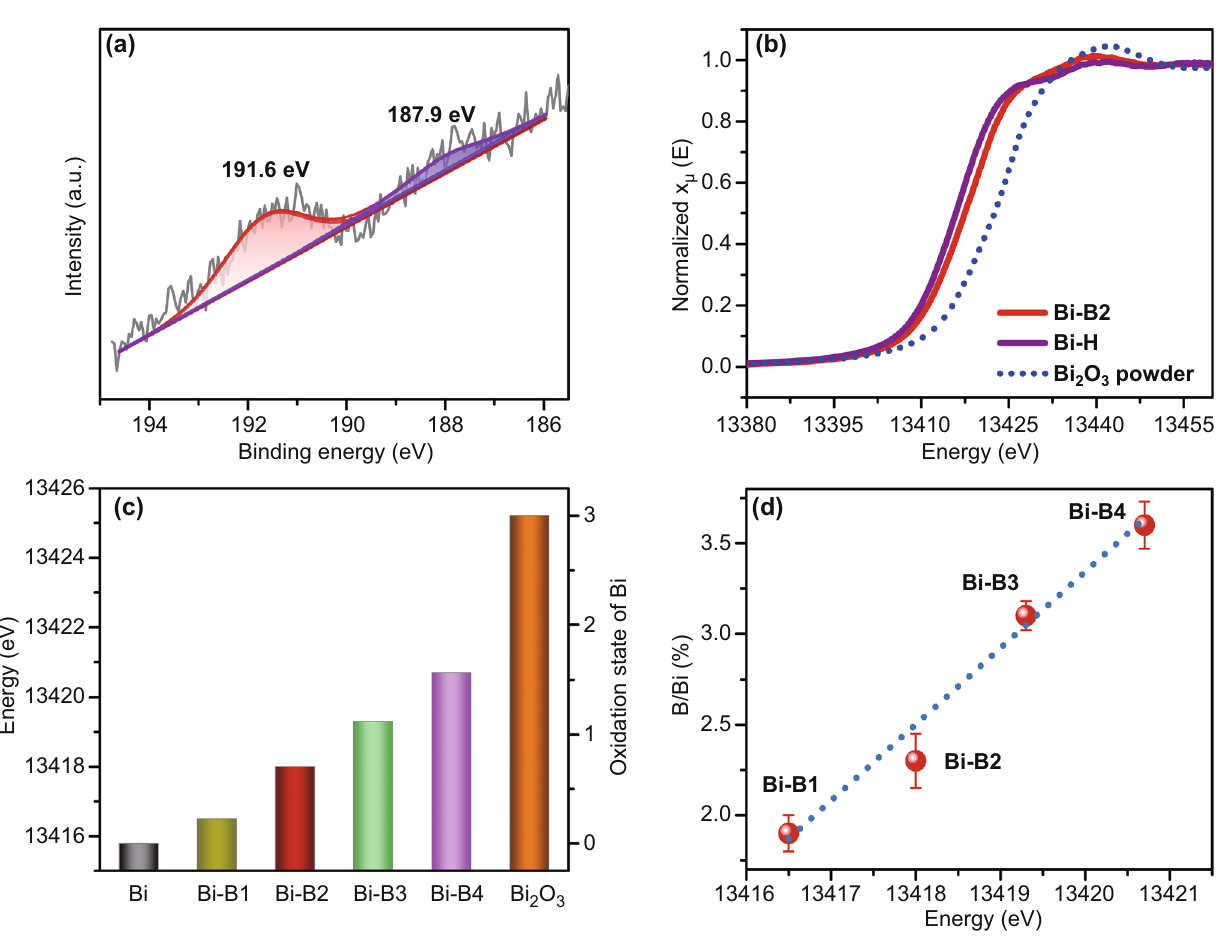
Fig. 2 a High‑resolution XPS B 1s spectra of Bi‑B2, b Bi L‑edge XANES spectra of Bi‑B2 and Bi‑H samples, c oxidation state of Bi and d the relationship between the ratio of B/Bi related and the absorption edge position obtained from Bi L‑edge XANES in different